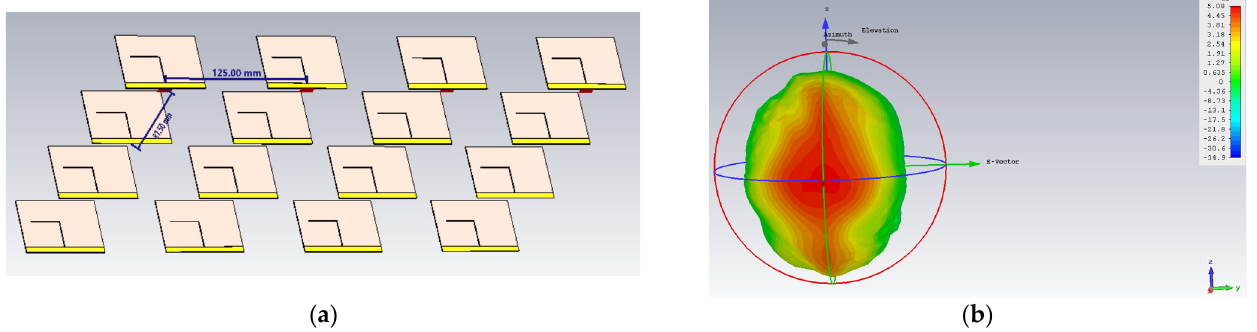
Figure 12. ( a ) Array of a 4 × 4 dipole element; ( b ) Element pattern within an array of 4 × 4 dipole elements.